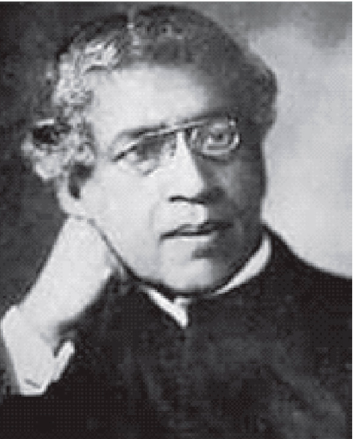
Figure 5. Jagadish Chandra Bose (1858–1937).